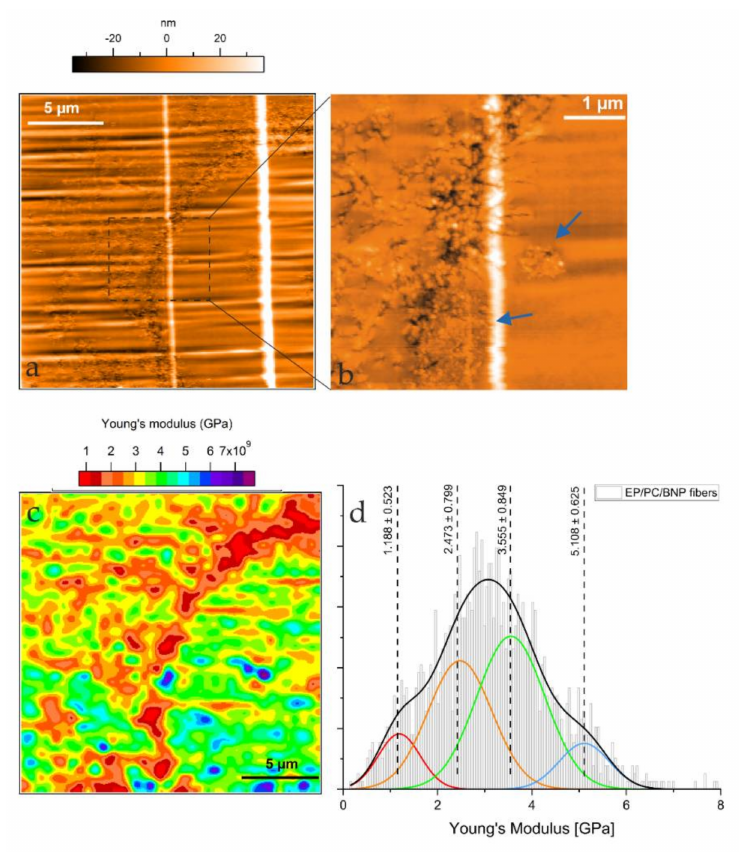
Figure 5. ( a ) Topography of an 80 × 80 µ m 2 area of the composite showing a collapsed PC/BNP fiber inside the epoxy matrix; ( b ) Zoomed-in area showing the topographic features of the area in ( a ), the blue arrows indicate the features which correspond to BNP domains; ( c ) Young’s modulus map of the area shown in ( a ); ( d ) Histogram of the Young’s modulus of the scanned area. A separated ellipsoidal rough structure, of around 1 µ m in diameter, is detectable in the EP-rich phase; this domain is indicated with the blue arrows in Figure 5b, which are associated to BNP domains, according to the previous micrographs from EP/BNP systems shown in Figure 4. The BNP domains were expected to show increased stiffness